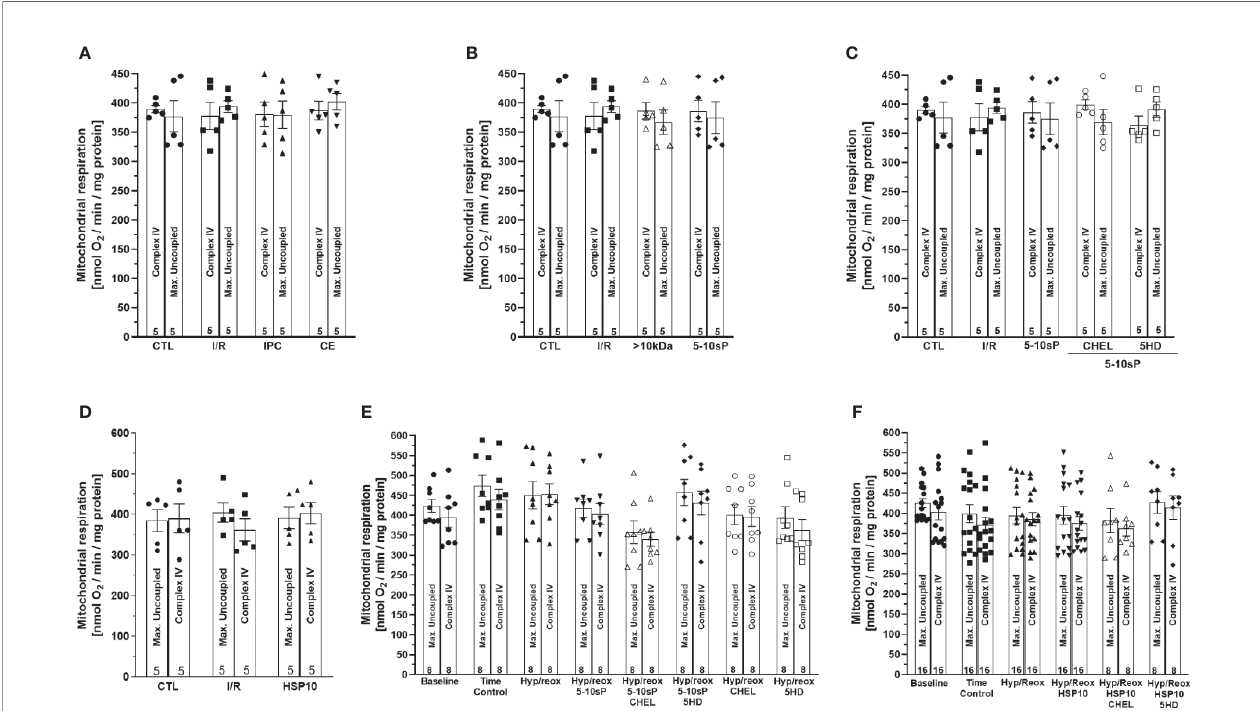
FIGURE 3 | Complex IV respiration with TMPD and ascorbate and maximal uncoupled oxygen uptake with FCCP of isolated mitochondria from rat hearts. (A – D) Isolated mitochondria from hearts submitted to I/R. Control (CTL), ischemia/reperfusion (I/R), ischemic preconditioning (IPC), preconditioned coronary ef fl uent transfer (CE), coronary ef fl uent fraction 5 – 10 kDa (5 – 10-sP) transfer, coronary ef fl uent fraction >10 kDa (> 10 kDa) transfer, 5 – 10-sP plus PKC inhibitor chelerythrine or mitochondrial KATP channel blocker 5HD. (E , F) Isolated mitochondria from hearts submitted to I/R under 10 kDa-mitochondrial heat shock protein (HSP10) perfusion. Mitochondria respiration submitted to hypoxia/reoxygenation and (F) HSP10 or (E) 5 – 10-sp with or without chelerythrine or 5HD incubation. Number in each column is n of